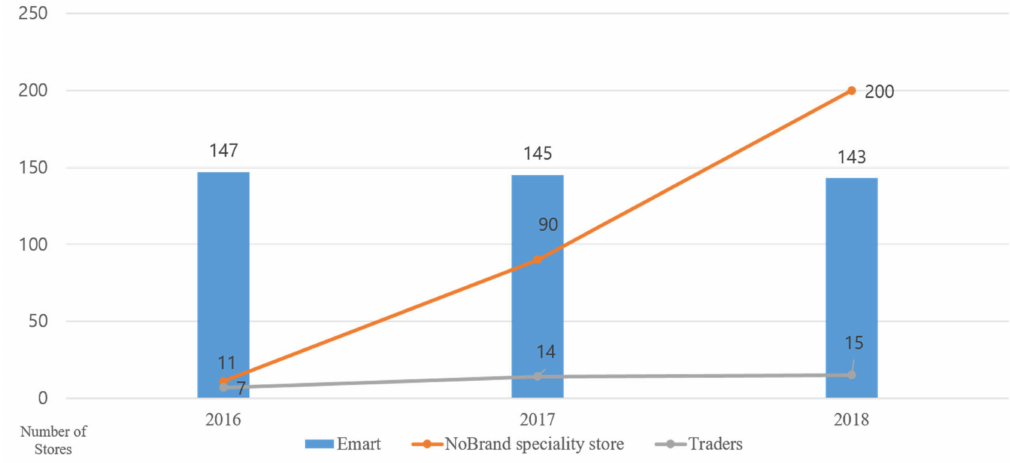
Figure 2. Number of Emart, NoBrand specialty and traders stores. Source: Hankyung (2019) [34].